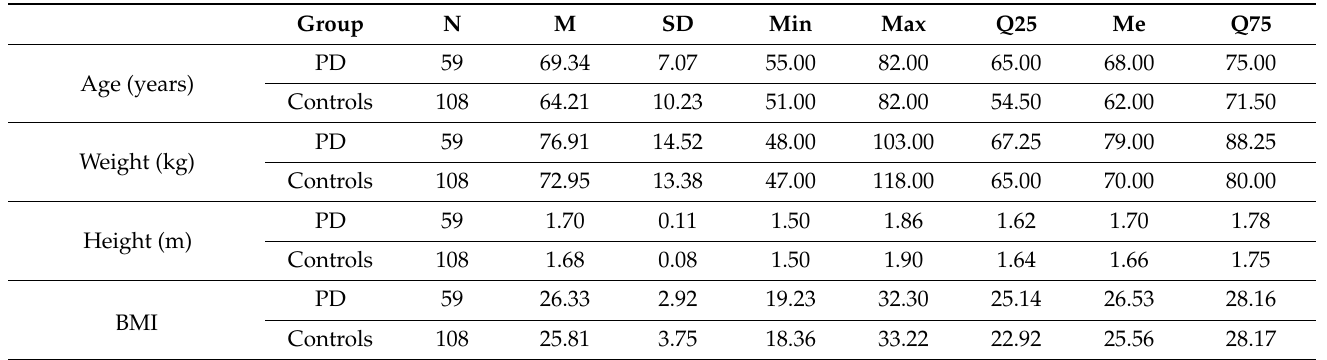
Table 1. Characteristics of patients with PD and age-matched healthy controls.